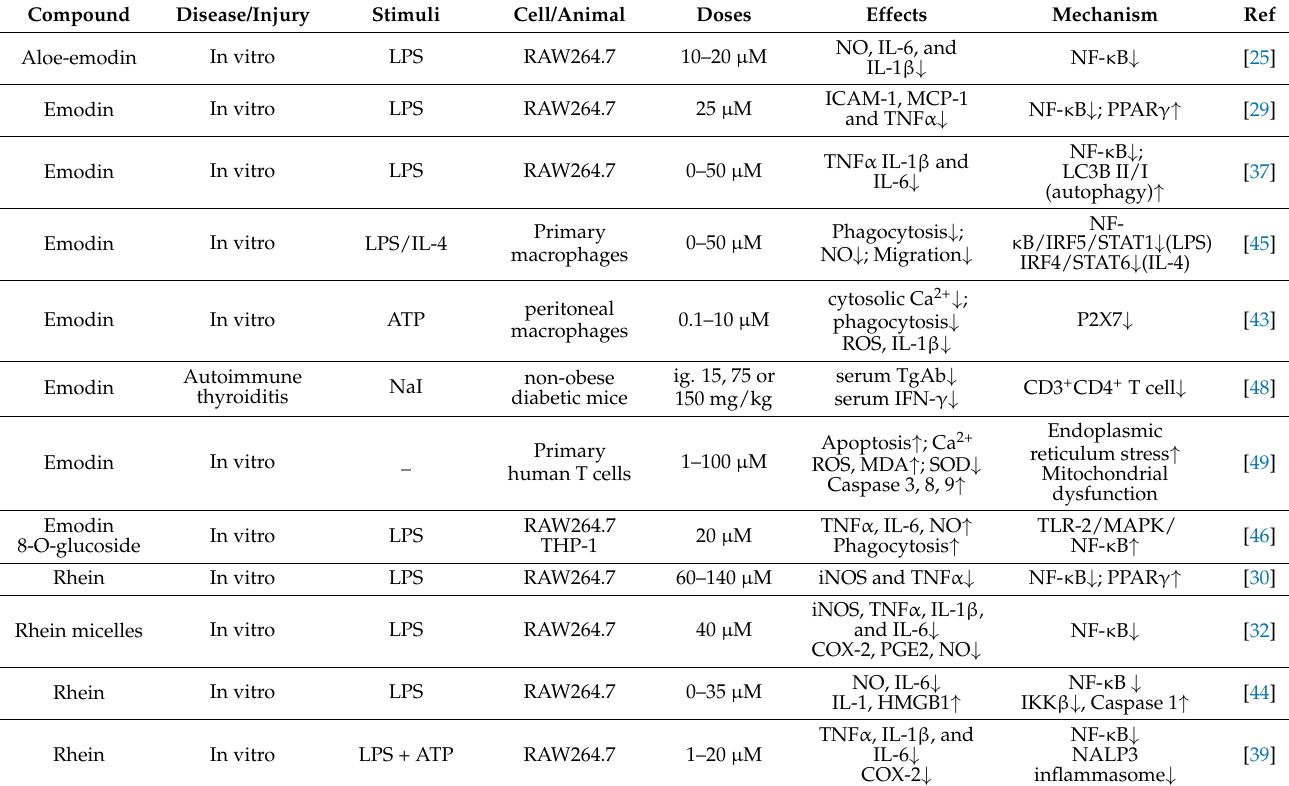
Table 1. Effects and mechanism of AQs on immune